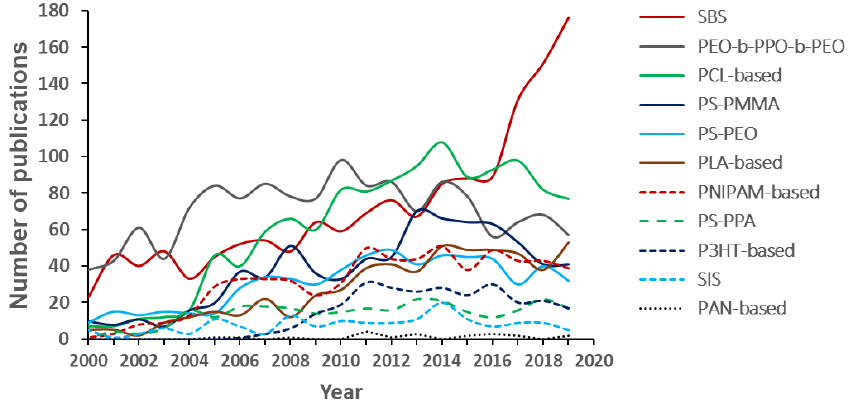
Figure 12. Trend for the number of publications referring to representative block copolymers from 2000 to 2019.